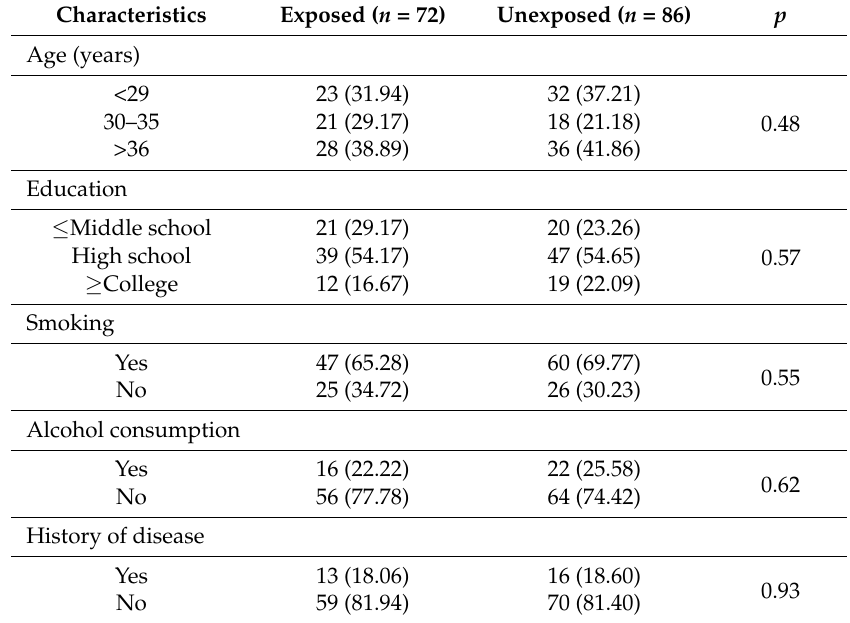
Table 1. Characteristics of workers in the BPA-exposed and unexposed groups.